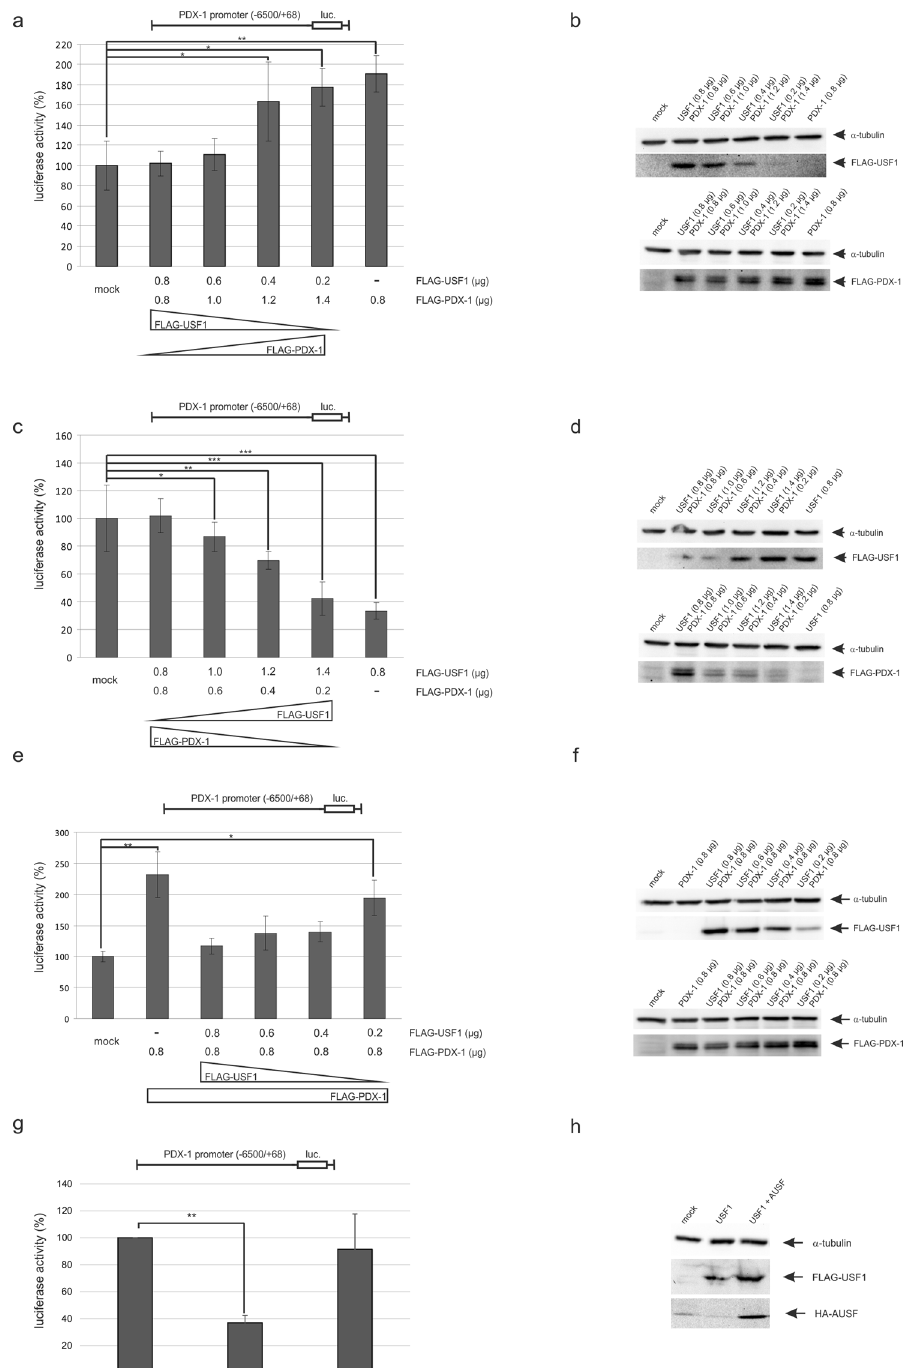
Figure 1. Reporter assays after transfection of INS-1 cells with USF1 and PDX-1 at different concentrations. ( a ) INS-1 cells were transfected with the PDX-1 promoter construct − 6500/ + 68-STF-luc and with different amounts of FLAG-USF1 (0.8 µ g–0.2 µ g) and FLAG-PDX-1 (0.8 µ g–1.4 µ g) or the empty vector (mock) as a control. ( c ) INS-1 cells were transfected with the PDX-1 promoter construct − 6500/ + 68-STF-luc and with different concentrations of USF1 (0.8 µ g–1.4 µ g) and PDX-1 (0.8 µ g–0.2 µ g) or the empty vector (mock) as a control. Luciferase activity was determined in quadruple; the activity in the mock transfected cells was set to 100%. Statistical analysis was performed by using Students t-test, * Significant difference p < 0.05, ** significant difference p < 0.01, *** significant difference p < 0.001. ( b ) and ( d ) The corresponding Western blot analysis of the FLAG-tagged USF1 and the FLAG-tagged PDX-1 is shown aside of each graph. Identification of FLAG- USF1 was performed with the rabbit polyclonal antibody sc-8983, PDX-1 was detected with the polyclonal rabbit antiserum against recombinant full-length mouse PDX-1. Due to the similar molecular weight of USF1 and PDX-1 we performed two Western blots. An α -tubulin antibody was used to demonstrate equal loading